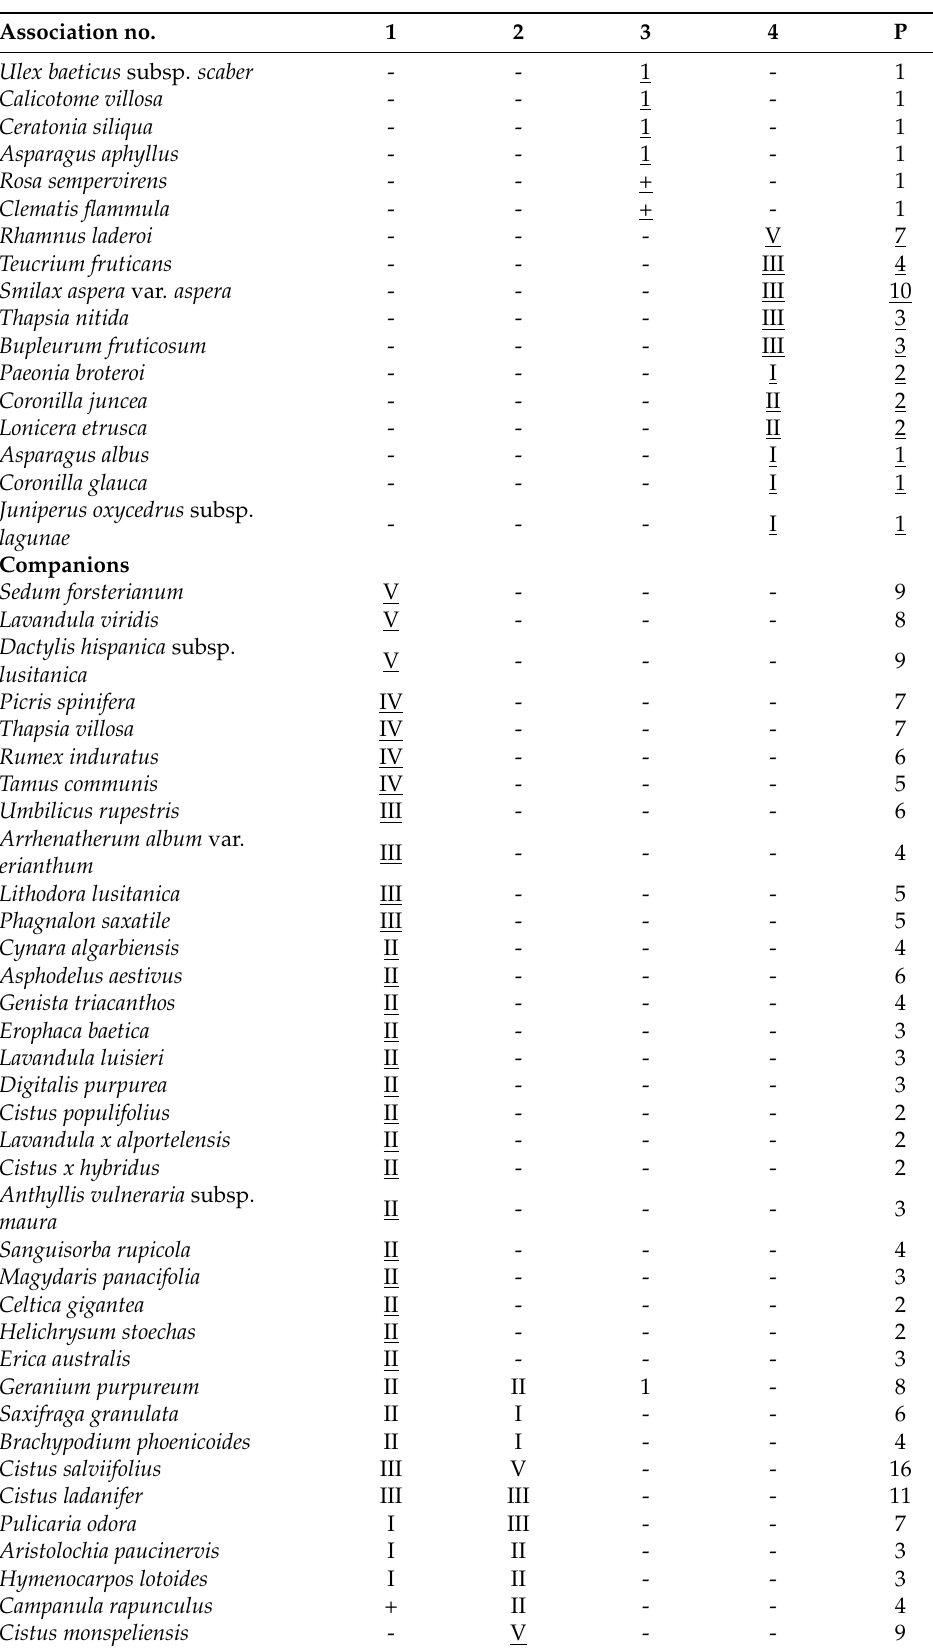
Table A1. Cont. Association